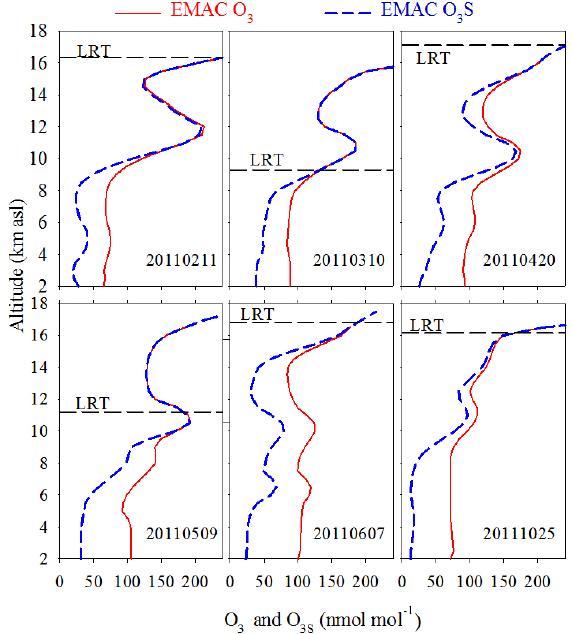
Figure 4. Vertical profiles of EMAC-simulated ozone and strato- spheric ozone tracer (O 3 s) during the SOPs over Nainital. The height of the lapse rate tropopause (LRT) from EMAC, calculated using the WMO definition, is also